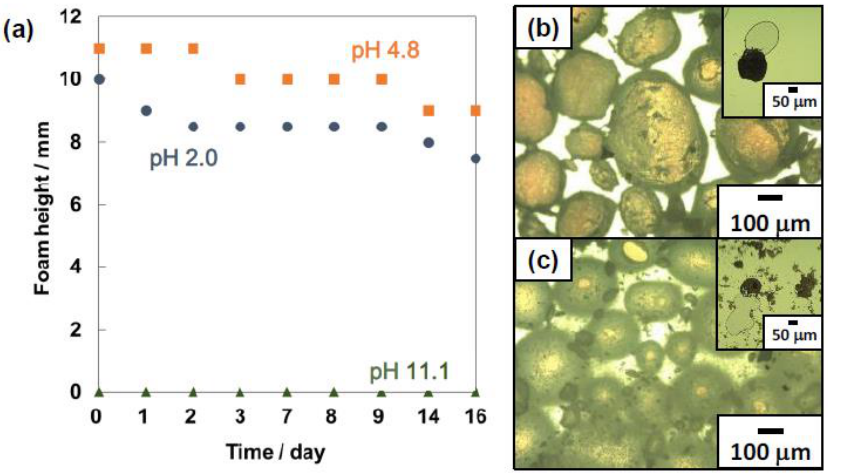
Figure 2. ( a ) Temporal change of foam height observed for the foams prepared at pH 2 (●), pH 4.8 ( ■ ), pH 11.1 ( ▲ ). ( b , c ) Optical micrographs of bubbles stabilized with ACMPA-PS particles prepared at ( b ) pH 2.0 and ( c ) 4.8. Insets of ( b , c ) show the bubbles between glass substrates after the application of pressure. An inset of ( b , c ) shows the bubbles after the application of pressure between glass substrates.